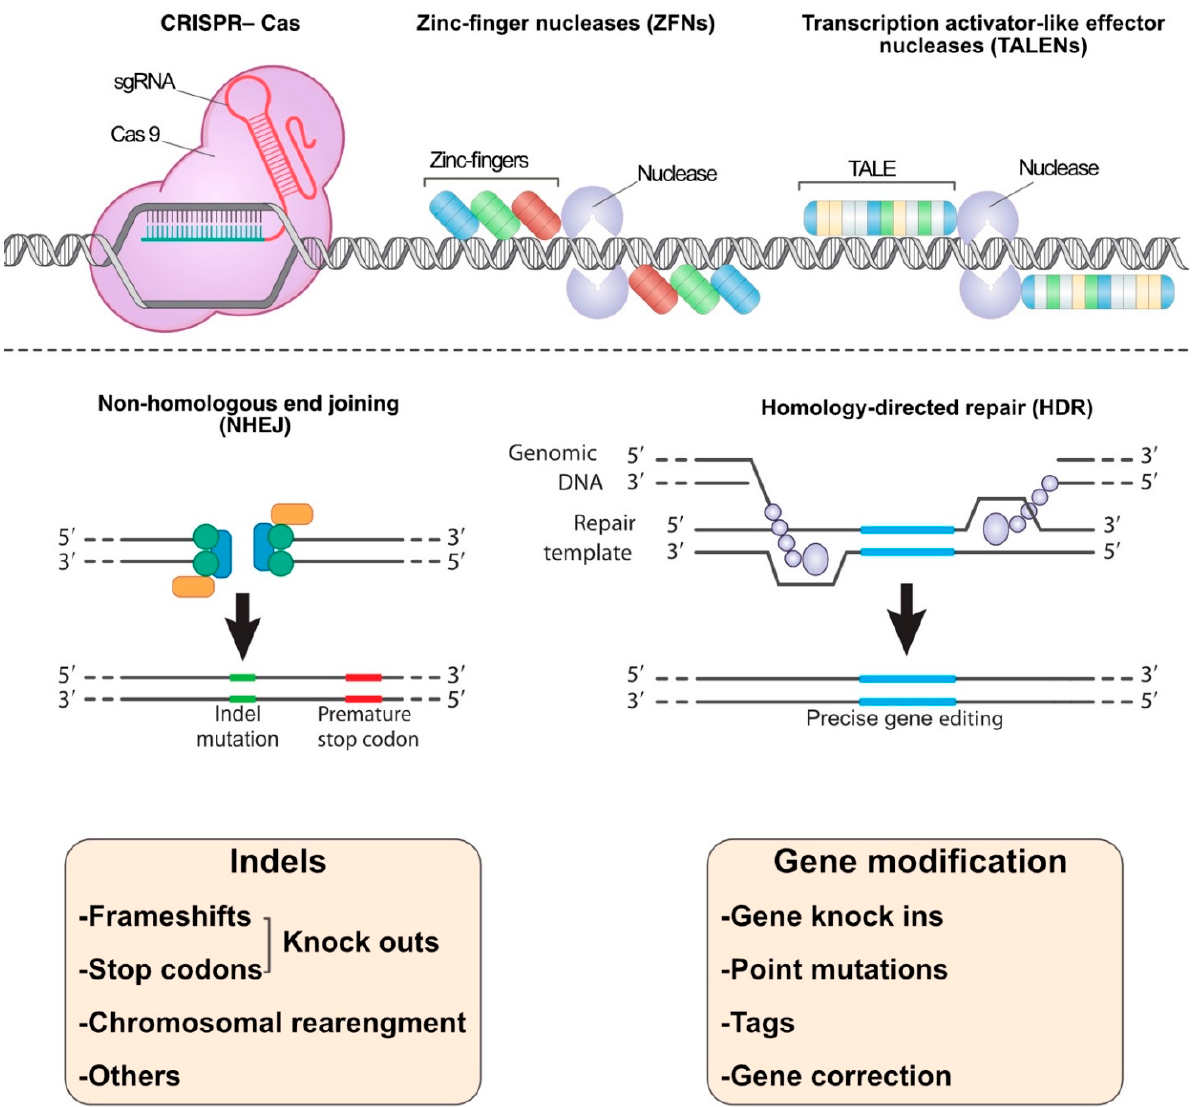
Figure 1. The common nucleases in the genome-editing methods: CRISPR, TALENs, and ZFNs systems. These nucleases break double-strand DNA targets, and then the breakage sites are repaired by non-homologous end joining (NHEJ) or homology-directed repair (HDR) mechanisms. Indels (refer to insertion–deletion mutations) may lead to gene knockouts and chromosomal rearrangement. HDR methodology could be used in gene modification i.e., gene knock-ins, point mutations, tags adding, and gene editing.